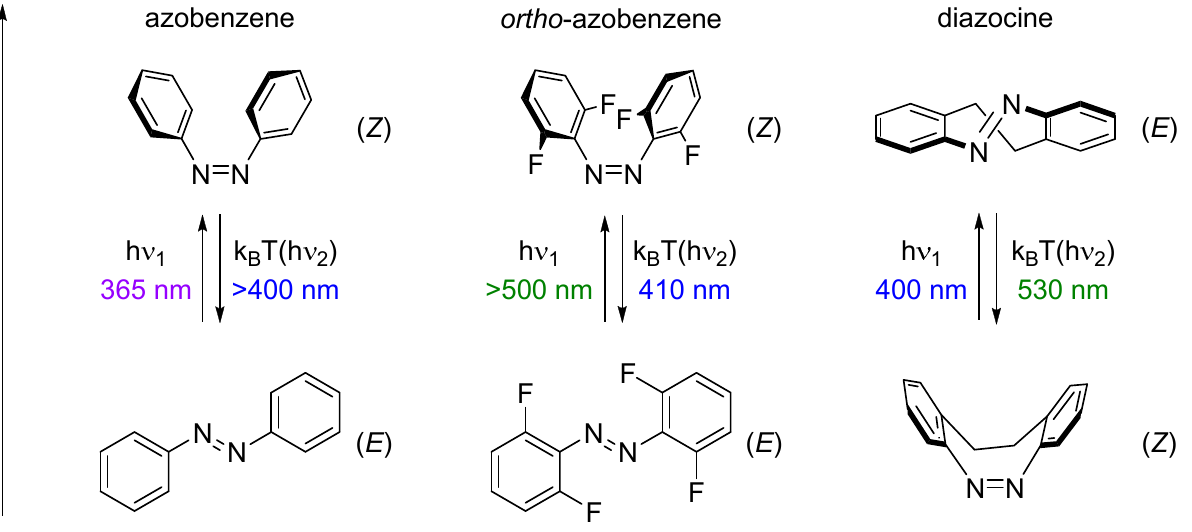
Figure 1. Isomerization of azobenzene [24] , tetra-ortho-fluorinated azobenzene [48] and diazocine [51] .